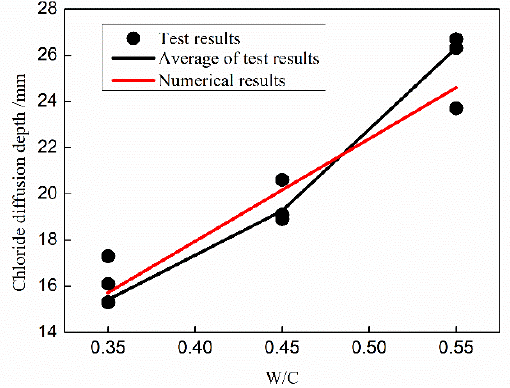
Figure 7. Chloride ion transport depth at 1.0 MPa.